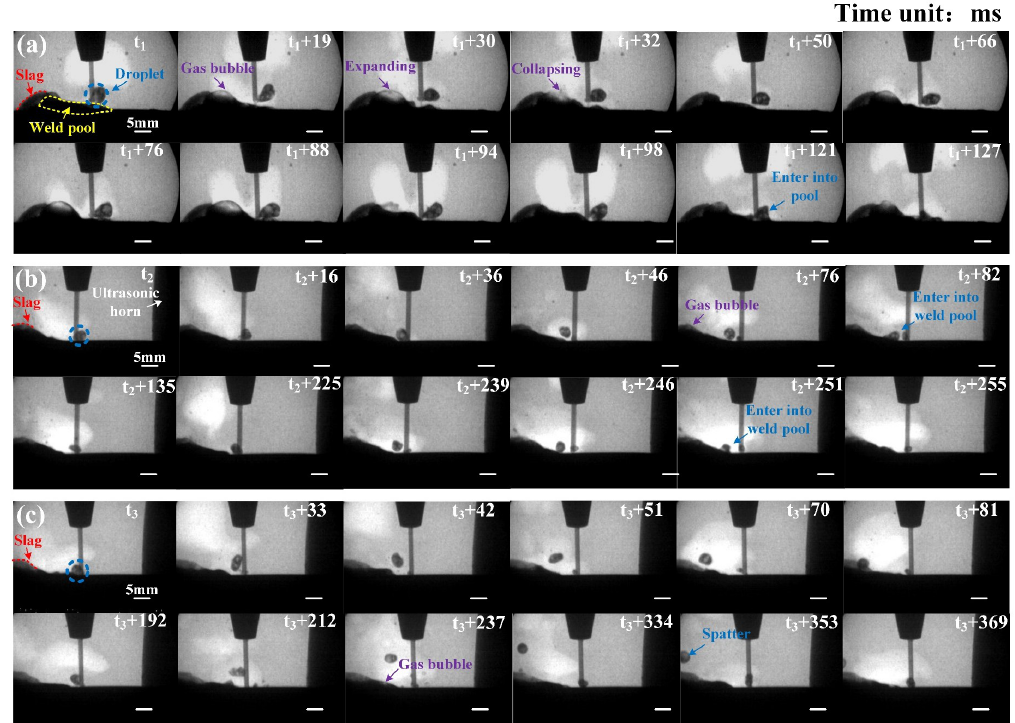
Figure 8. X-ray images of melt flow and droplet transfer process obtained at di ff erent conditions: ( a ) without ultrasonic; ( b , c ) ultrasonic output power was 40% and 80% of the maximum power (1200 W), respectively.